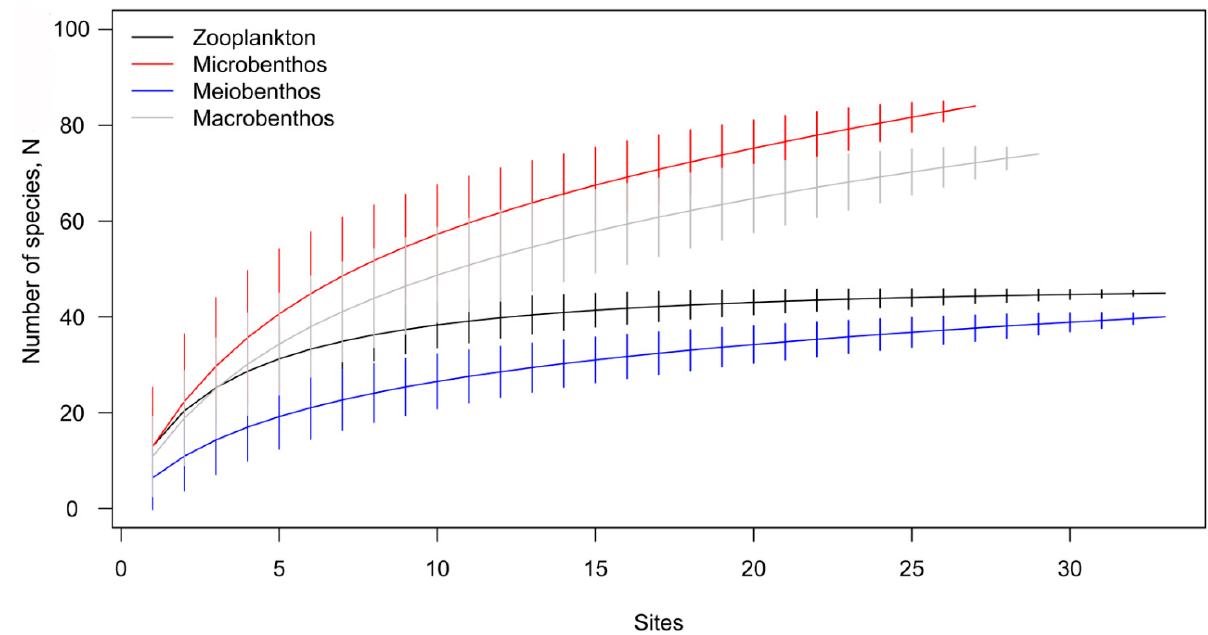
Figure 3. Species accumulation curves for zooplankton (black line), benthic protists (red line), meiobenthos (blue line) and macrozoobenthos (gray line) depending on the number of samples studied (N—species number).